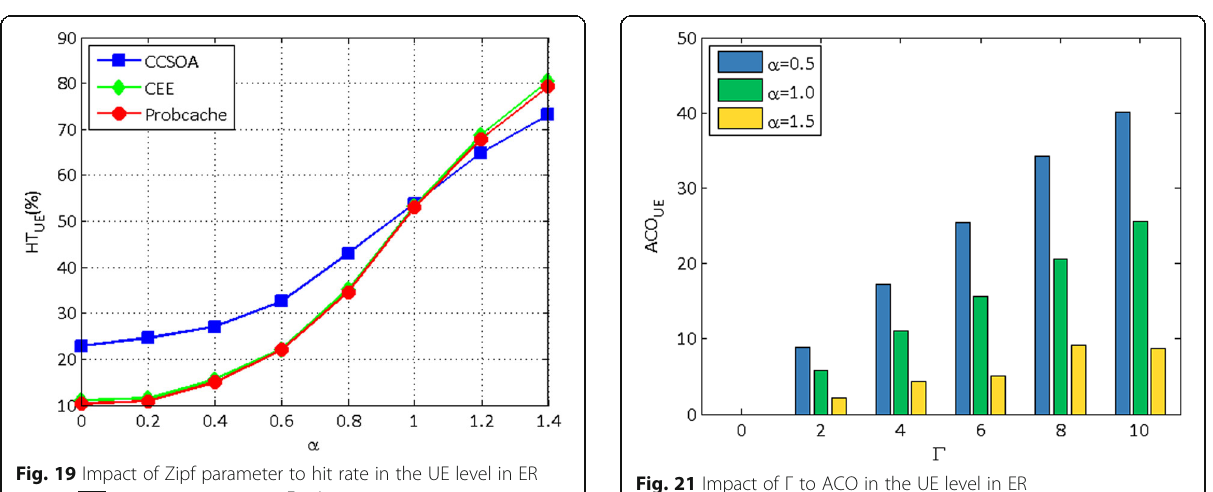
Fig. 21 Impact of Γ to ACO in the UE level in ER